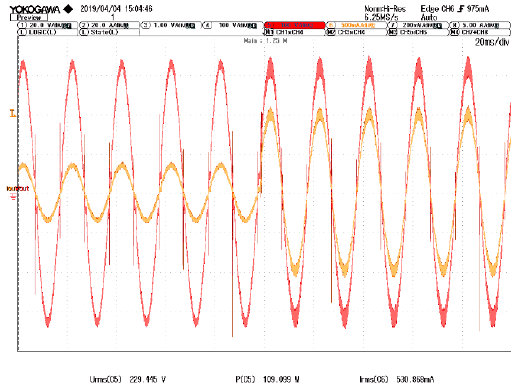
Figure 26. Load transition of 50 to 150 W.